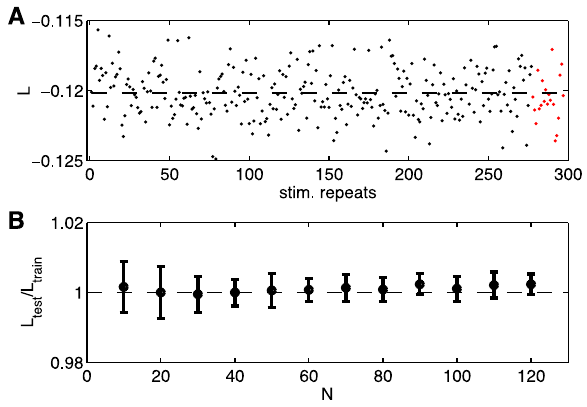
Figure 4. A test for overfitting. ( A ) The per-neuron average log- = N ) under the probability of data (log-likelihood, L ~ h log P ( s ) i expt pairwise model of Eq (19), computed on the training repeats (black dots) and on the testing repeats (red dots), for the same group of N =100 neurons shown in Figure 1 and 2. Here the repeats have been reordered so that the training repeats precede testing repeats; in fact, the choice of test repeats is random. ( B ) The ratio of the log-likelihoods on test vs training data, shown as a function of the network size N . Error bars are the standard deviation across 30 subgroups at each value of N . doi:10.1371/journal.pcbi.1003408.g004 are sufficiently long to estimate the probabilities of all of these individual states. But with N = 100, there are 2 100 * 10 30 possible states, and so it is not possible to ‘‘just measure’’ all the probabilities. Thus, we need another strategy for testing our models.